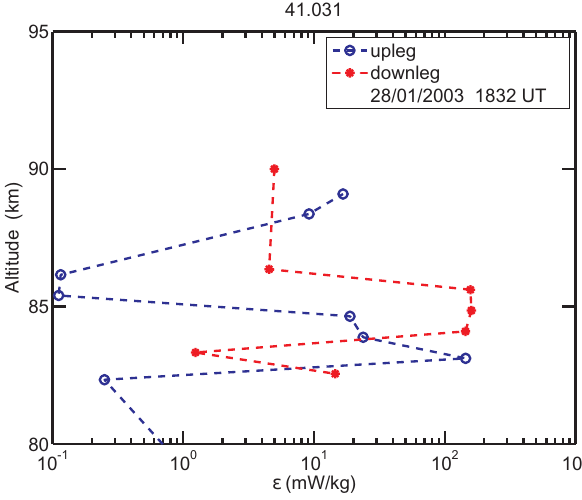
Fig. 19. Vertical profiles for the dissipation rate ( ε) during both upleg and downleg of MaCWAVE rocket flight NASA 41.031 on 28 January 2003. Note the large increase near 85km where wave- breaking was thought to